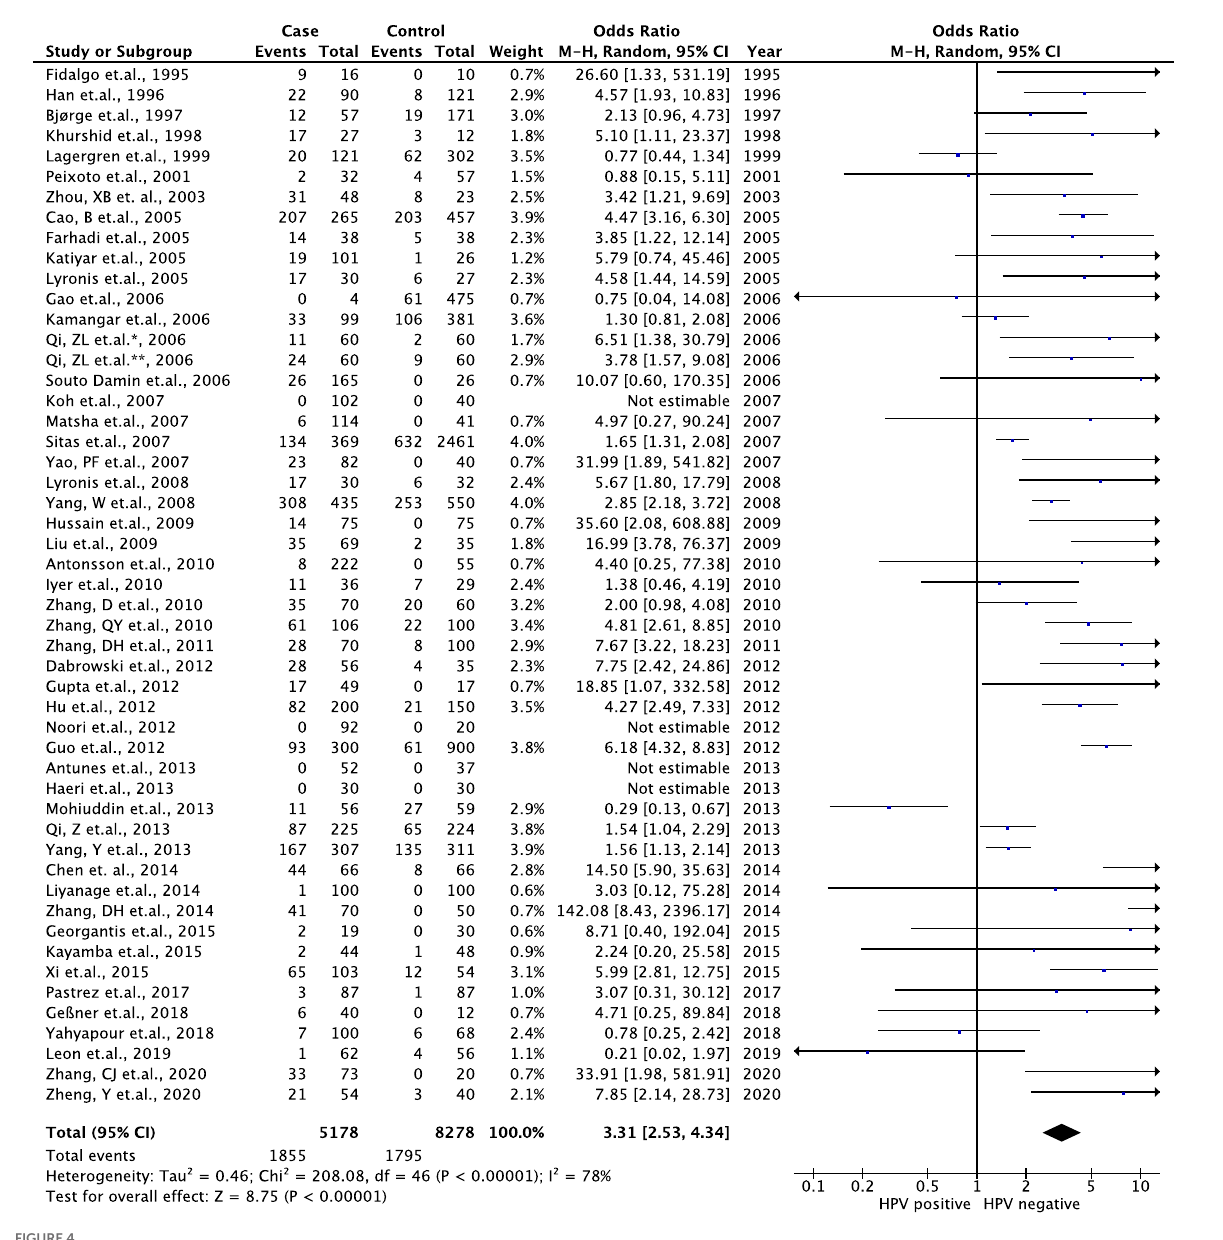
FIGURE 4 Association between HPV infection and EC risk in the meta-data analysis. Forest plots represented the pool odds ratios (ORs) and 95% CIs for the association between HPV infection and EC risk in each registered case–control